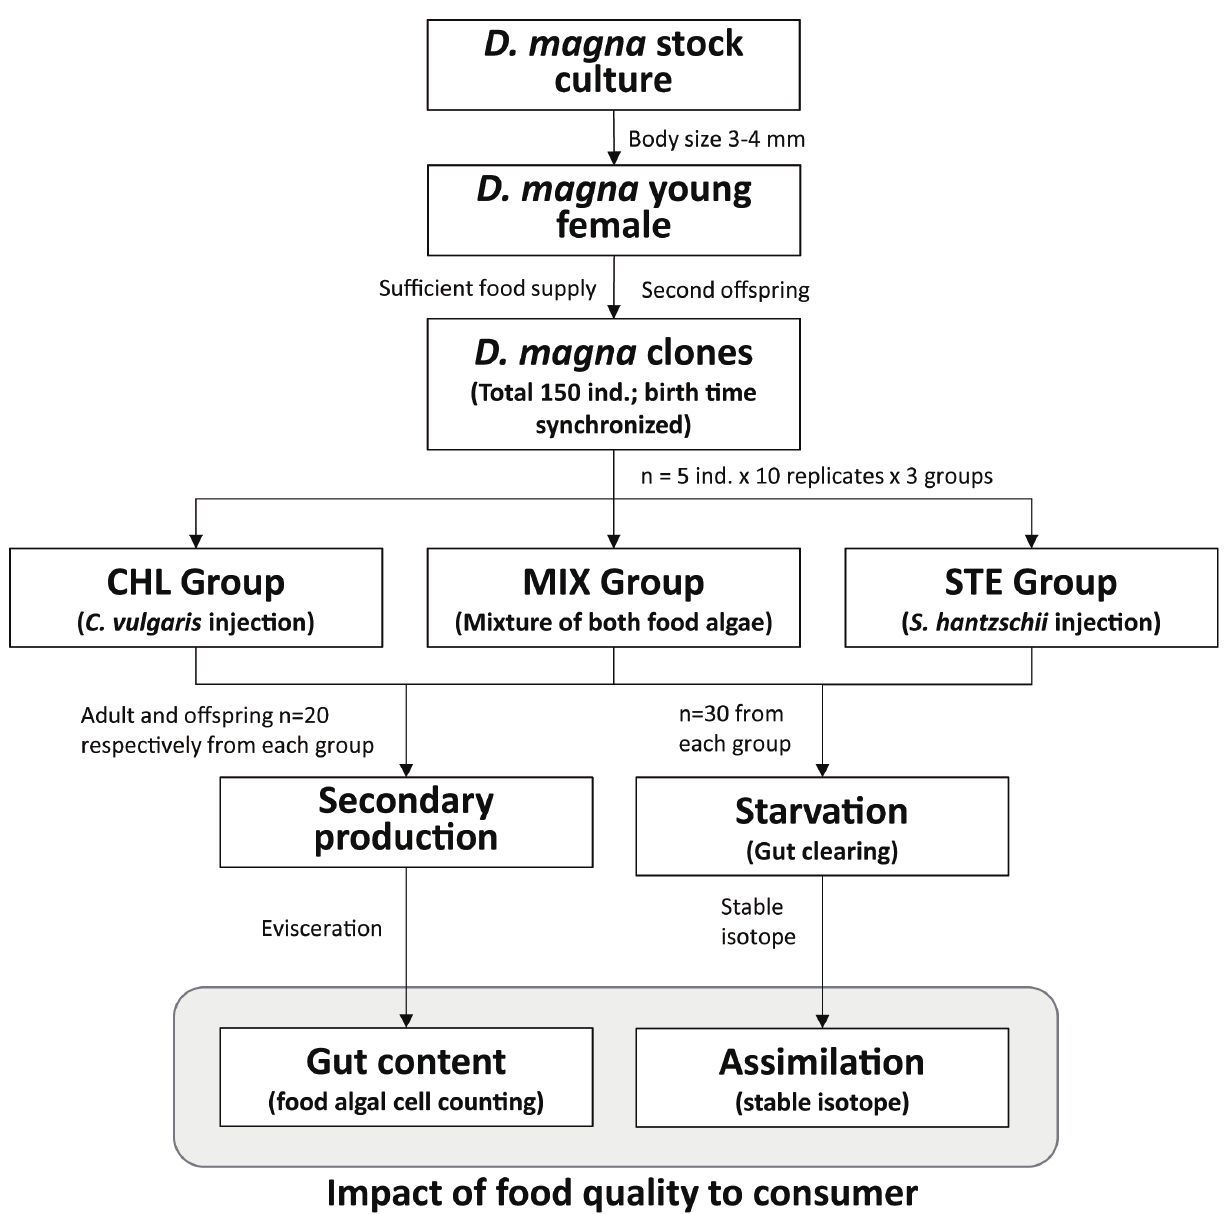
Figure 1. Schematic flowchart of the study. The shaded box indicates analytical processes that used the prepared samples in earlier stages of the experiment.